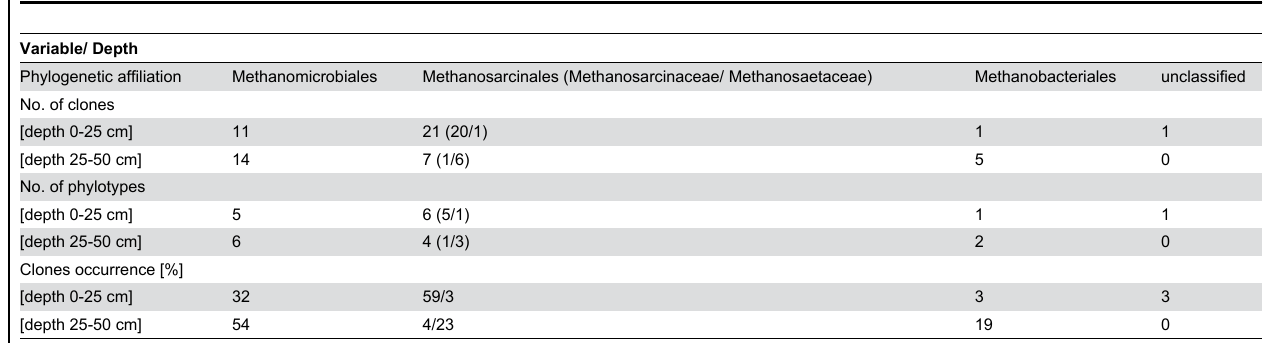
Table 3. Number of clones and phylotypes and their phylogenetic affiliation to each